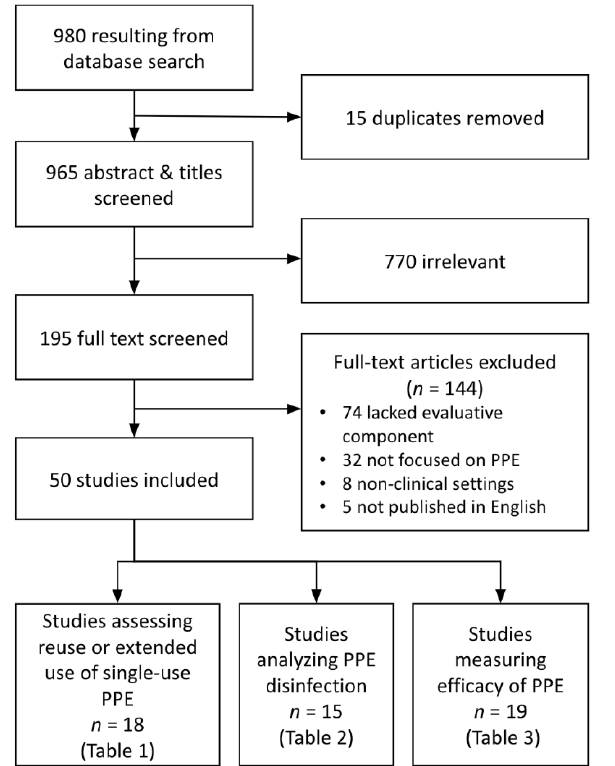
Figure 1. PRISMA Diagram showing literature screening process and initial sorting for analysis.